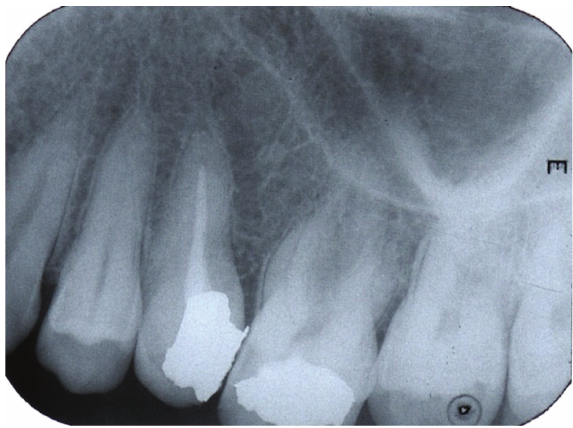
Figure 2: Periapical radiograph taken from the symmetrical region of the maxilla shows no unusual morphology of the teeth.